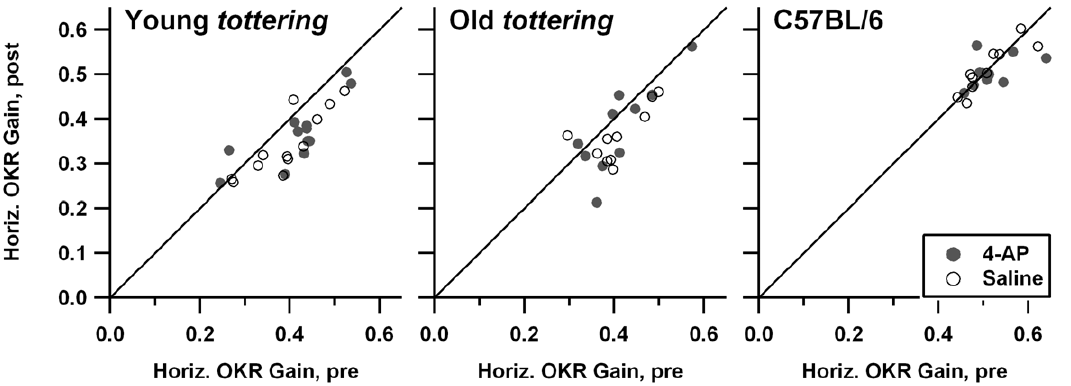
Figure 4. Comparison of yaw sinusoidal optokinetic reflex (OKR) gain before and after saline or 1.25 mg/kg 4-AP administration. Symbols and format are identical to Figure 1. Mutants exhibited habituation, without evidence of a 4-AP effect.